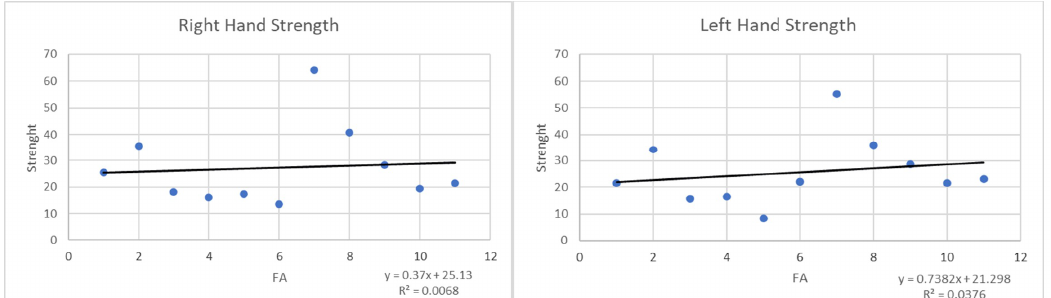
Figure 7. Correlation between the postoperative FA values and hand